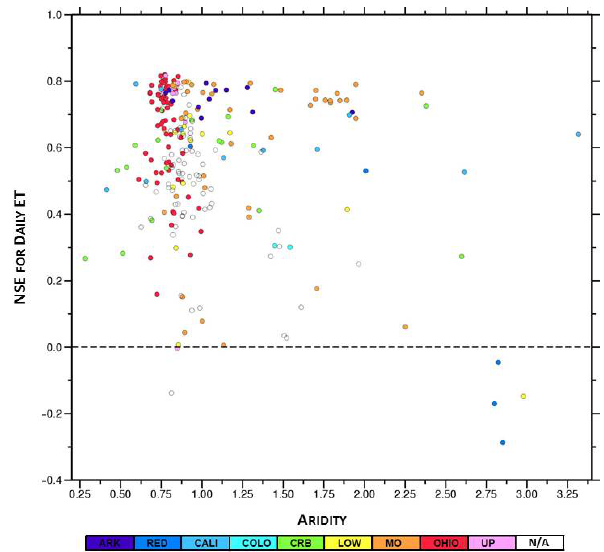
Fig. 9. NSE values for ULM calibrations to streamflow at a daily time step as a function of AI for the period 1991–2010. Shading of individual points denotes the major region for each tributary.